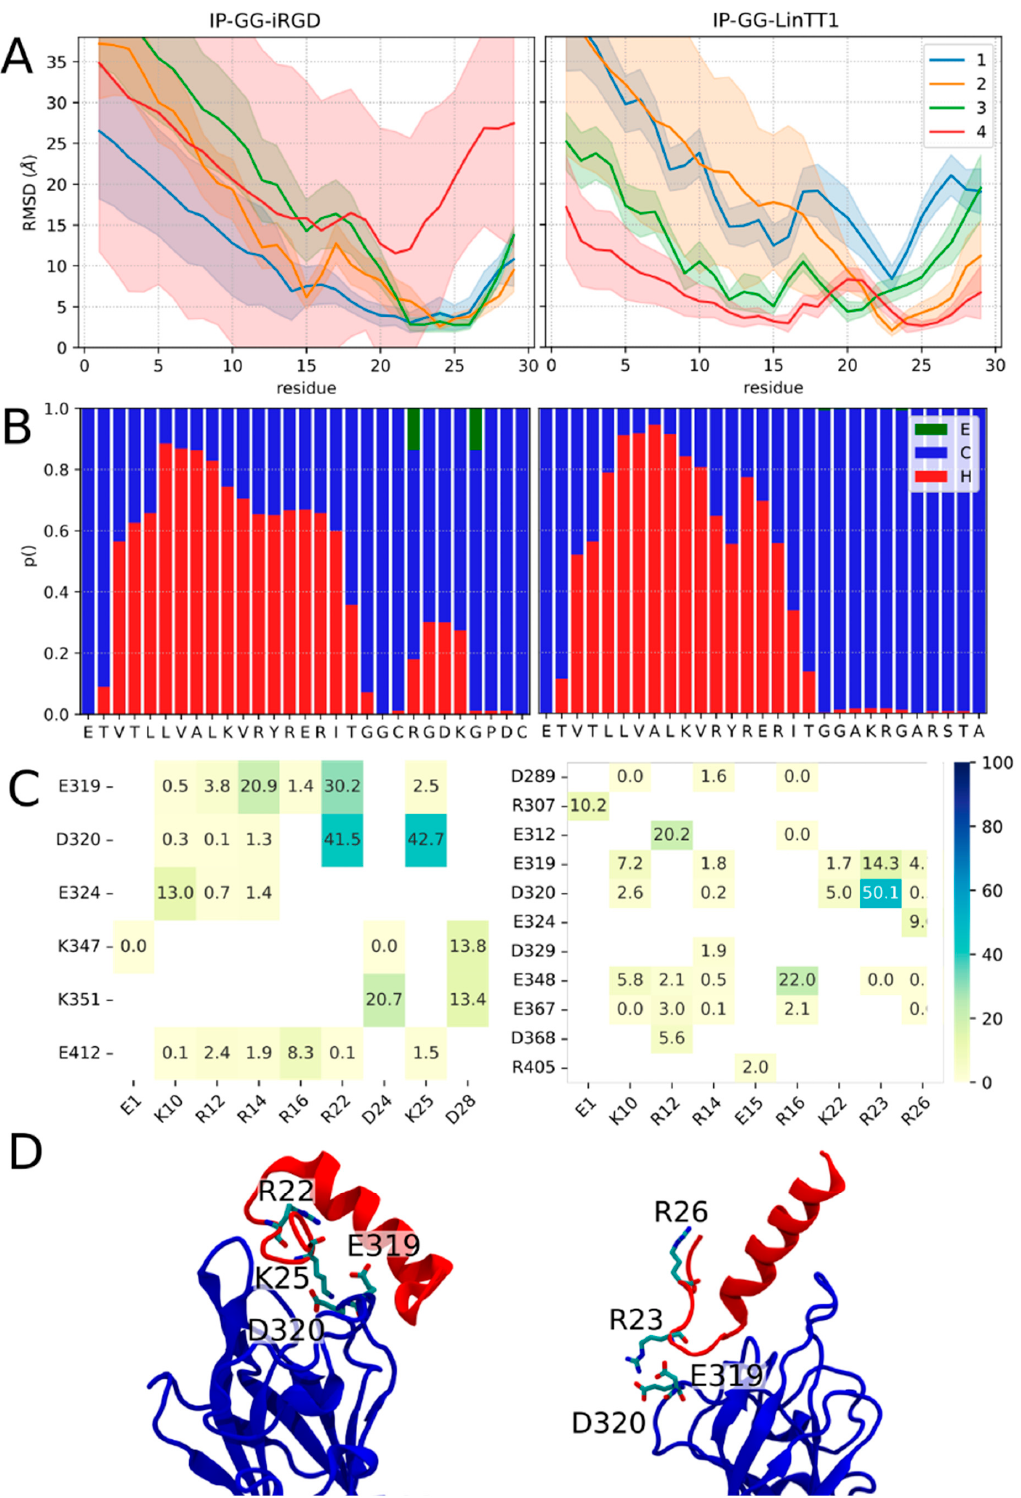
Figure 3. Non-cleaved Peptide stability secondary structure and interaction with Neuropilin1. The analyses are identical to those in Figure 2, for IR-GG-iRGD and IR-GG-LinTT1. ( A ) Upper panel: peptide RMSD per residue, colored by simulation replica; error bar represents the standard deviation of RMSD. ( B ) Secondary structure percentage of IR-GG-iRGD and IR-GG-LinTT1. ( C ) Frequency of salt bridge interaction between Neuropilin1 (y-axis) and peptides (x-axis). Only salt bridges with a frequency higher than 0.01 are shown. ( D ) Representative structure of the biggest cluster. All MD simulation frames were clustered based on the C-ter residues backbone